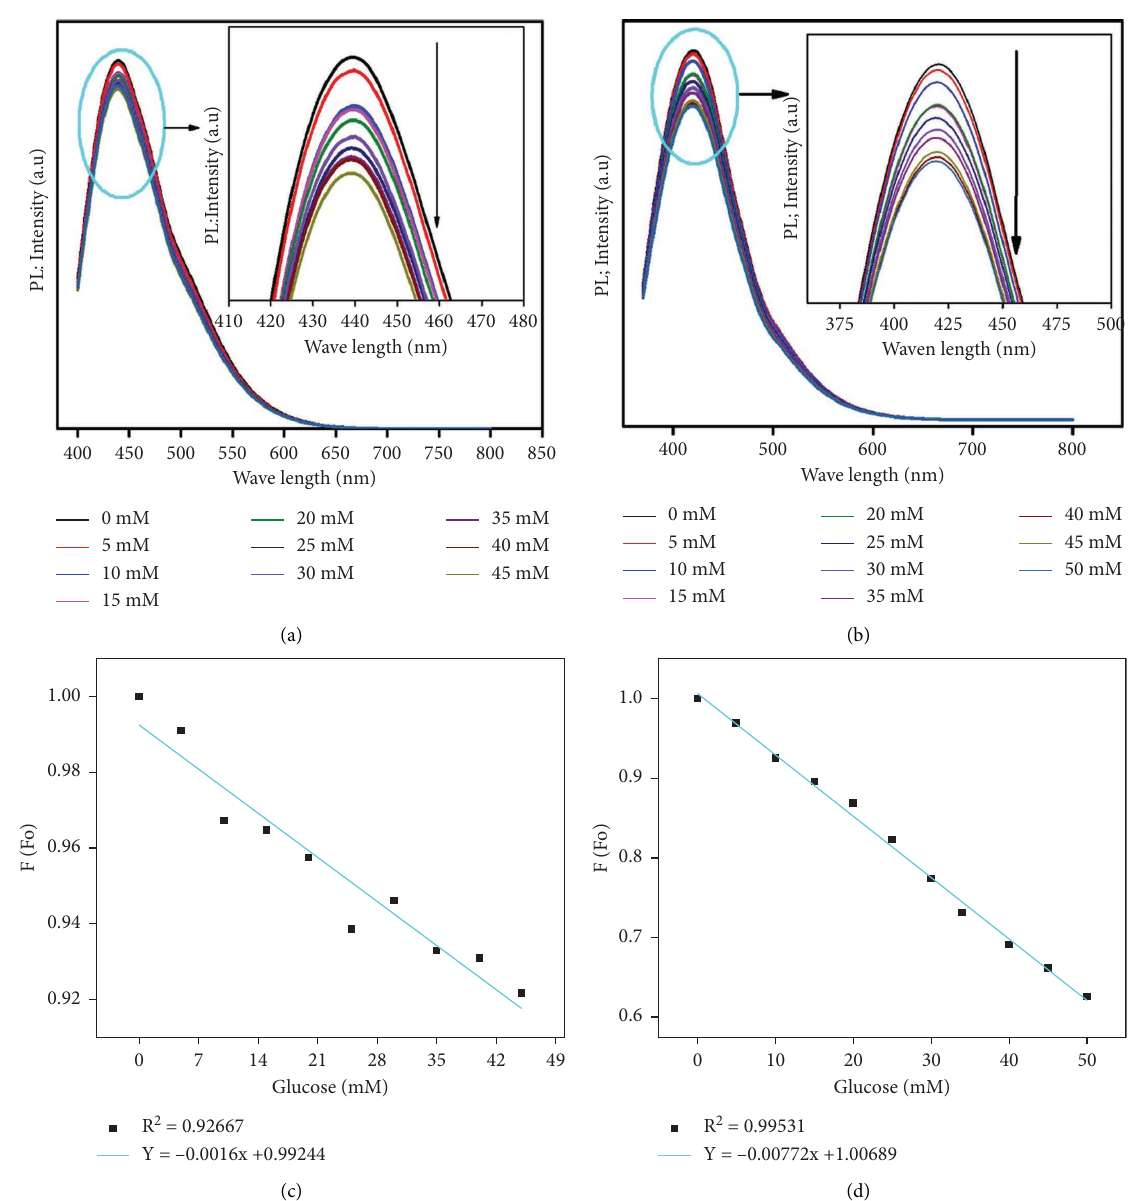
Figure 4: Te fuorescence quenching spectra of (a) GQDs and (b) BGQDs in the detection 0, 5, 10, 15, 20, 25, 30, 35, 40, 45, and 50mM concentrations of glucose. (c, d) Te respective plot of the fuorescence quenching for GQDs at λ � 439 and BGQDs at 417nm vs. the concentration of